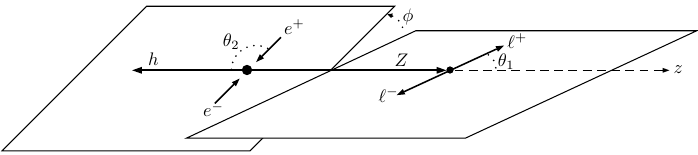
angles in a e + e event (taken from ref. [31]). (cid:18) 1 ; (cid:18) 2 ; (cid:30) (cid:0) ! hZ f g